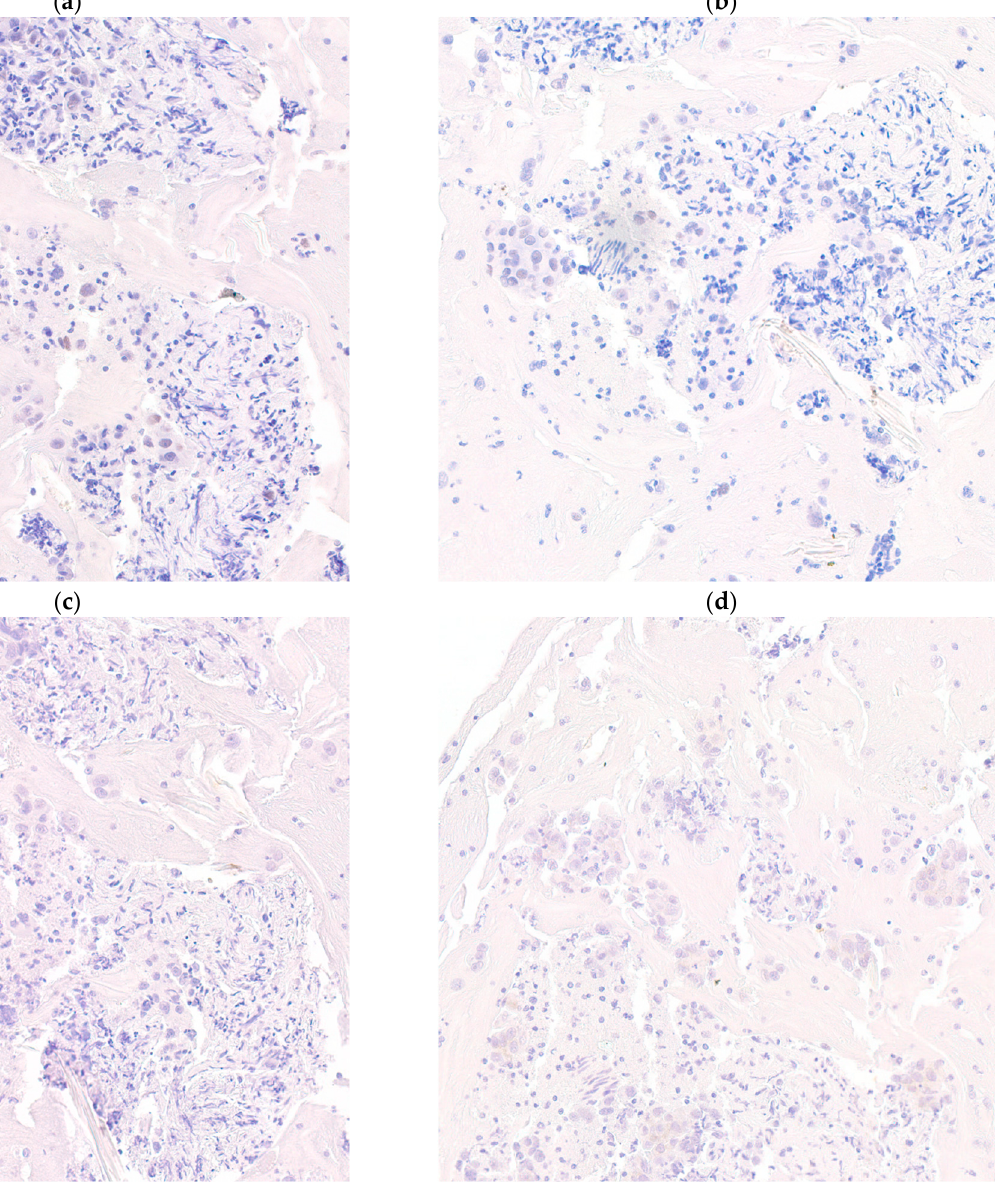
Figure 2. SOX10 positivity is negatively correlated to GATA3, gross cystic disease fluid protein-15 (GCDFP15) and mammaglobin expression. An estrogen receptor metastatic breast cancer showing weak SOX10 expression ( a ) (SOX10, 200× magnification) while negative to GATA3 ( b ) (GATA3, 200× magnification), GCDFP15 ( c ) (GCDFP15, 200× magnification) and mammaglobin ( d ) (mammaglo- bin, 200× magnification).